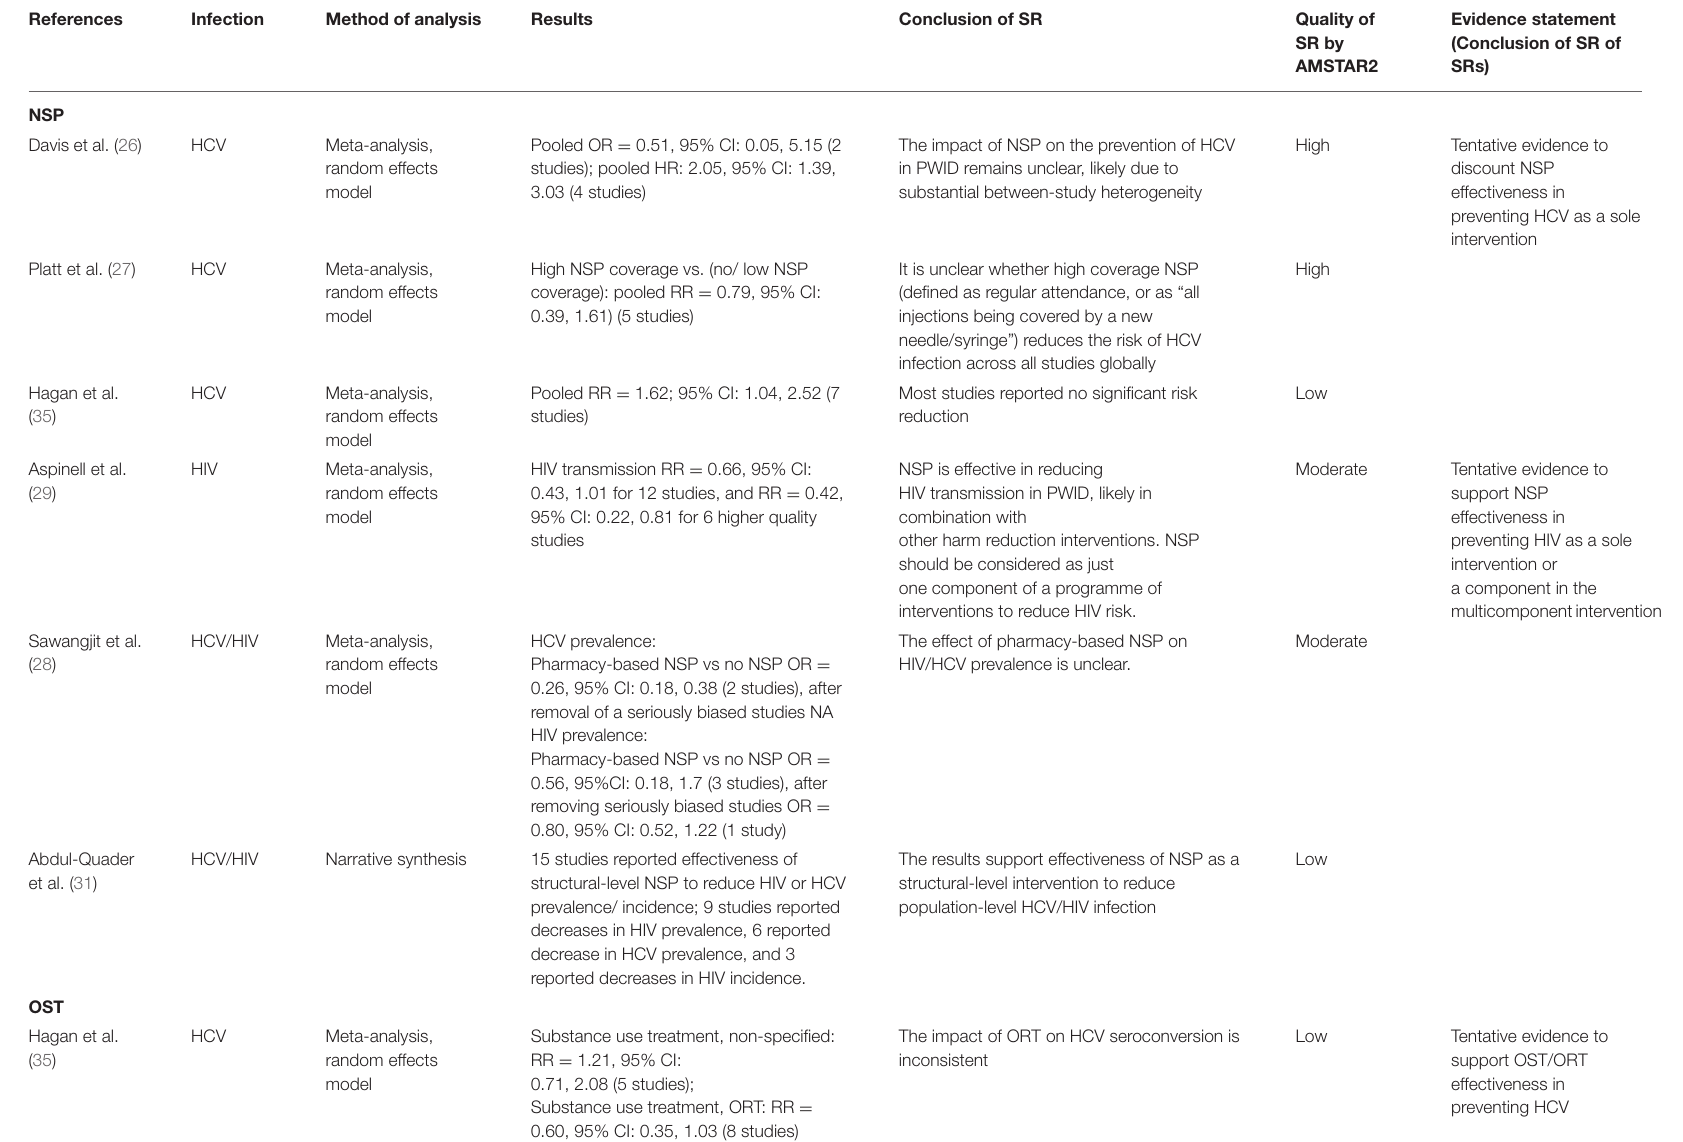
TABLE 5 | Summary of results for needle/syringe exchange and opioid substitution treatment to prevent HCV and HIV infections in opioid